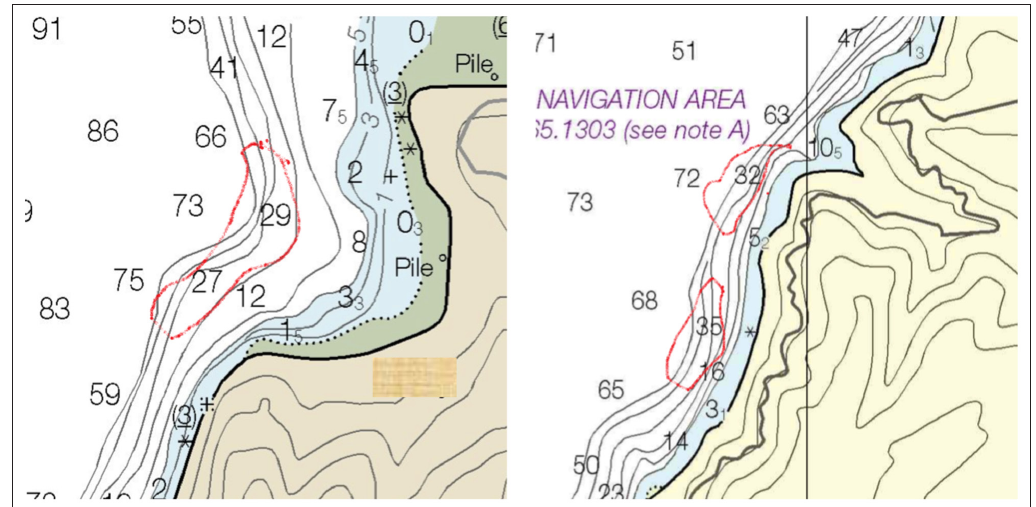
Figure 3: Example of maps showing locations where local anglers described where they used to fish for and catch ESA-listed